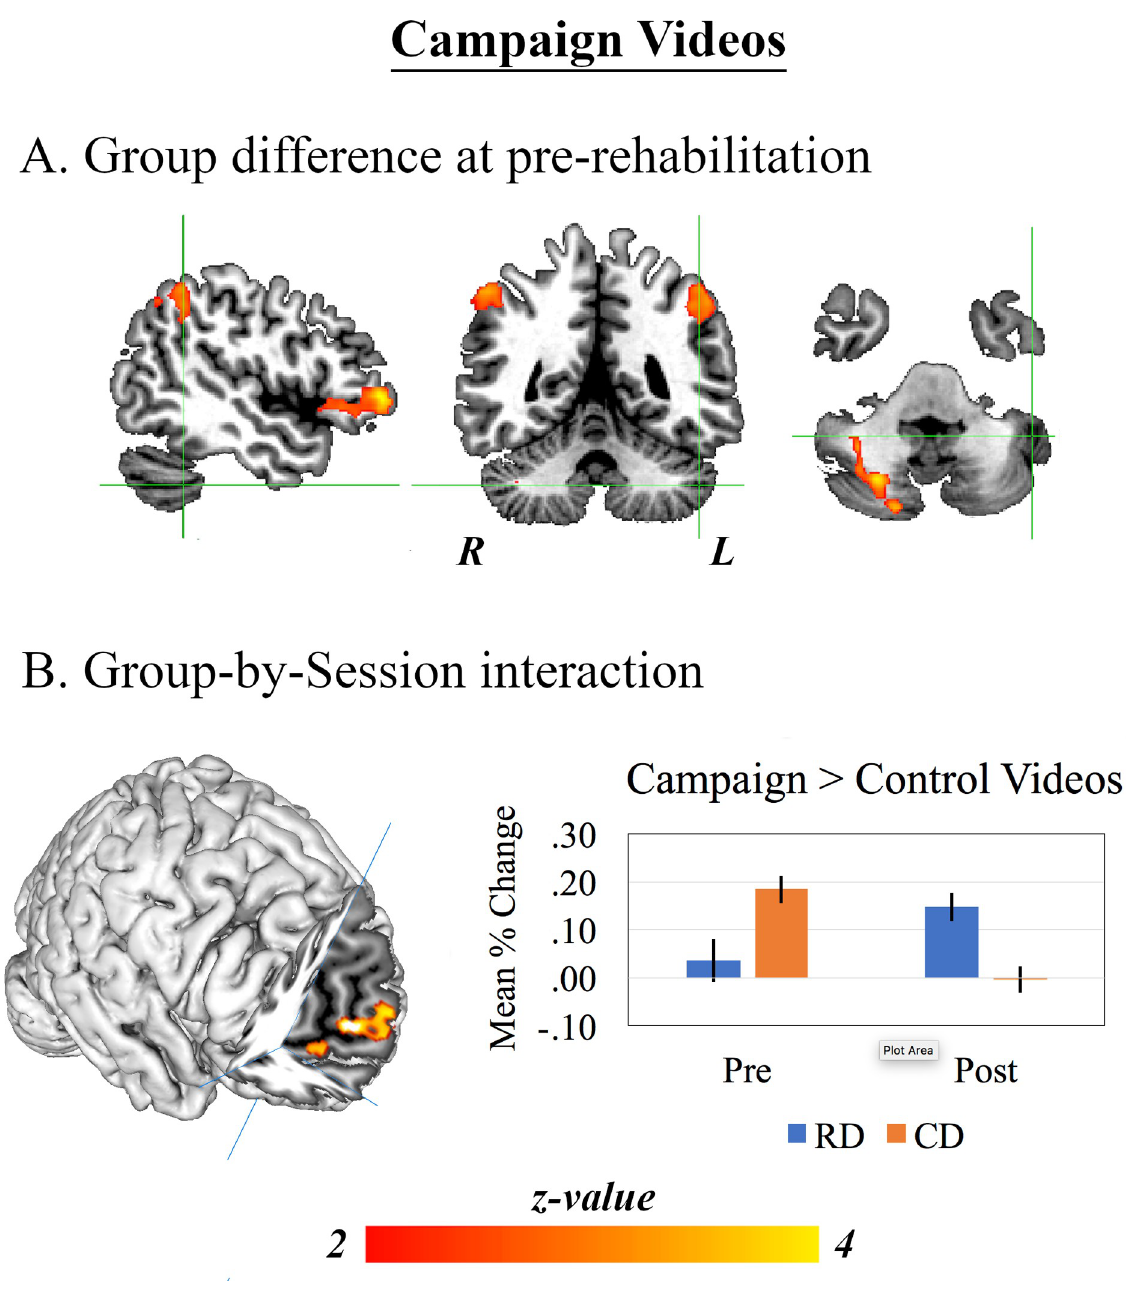
Fig 2. Results of the GLM analyses applied to data acquired during viewing of the campaign videos. A : Clusters of brain response in which the campaign > control video contrast was expressed significantly more in CDs than RDs during the pre-rehabilitation assessment. B : The single cluster of brain response within the medial prefrontal cortex in which the campaign > control contrast expressed an increase in RDs but a decrease in CDs between pre- and post-rehabilitation. The mean percent signal change extracted from all voxels comprising this cluster are also presented. Note : All whole-brain z-maps are shown after non-parametric permutation inference involving 5000 permutations, thresholded at p < .05.